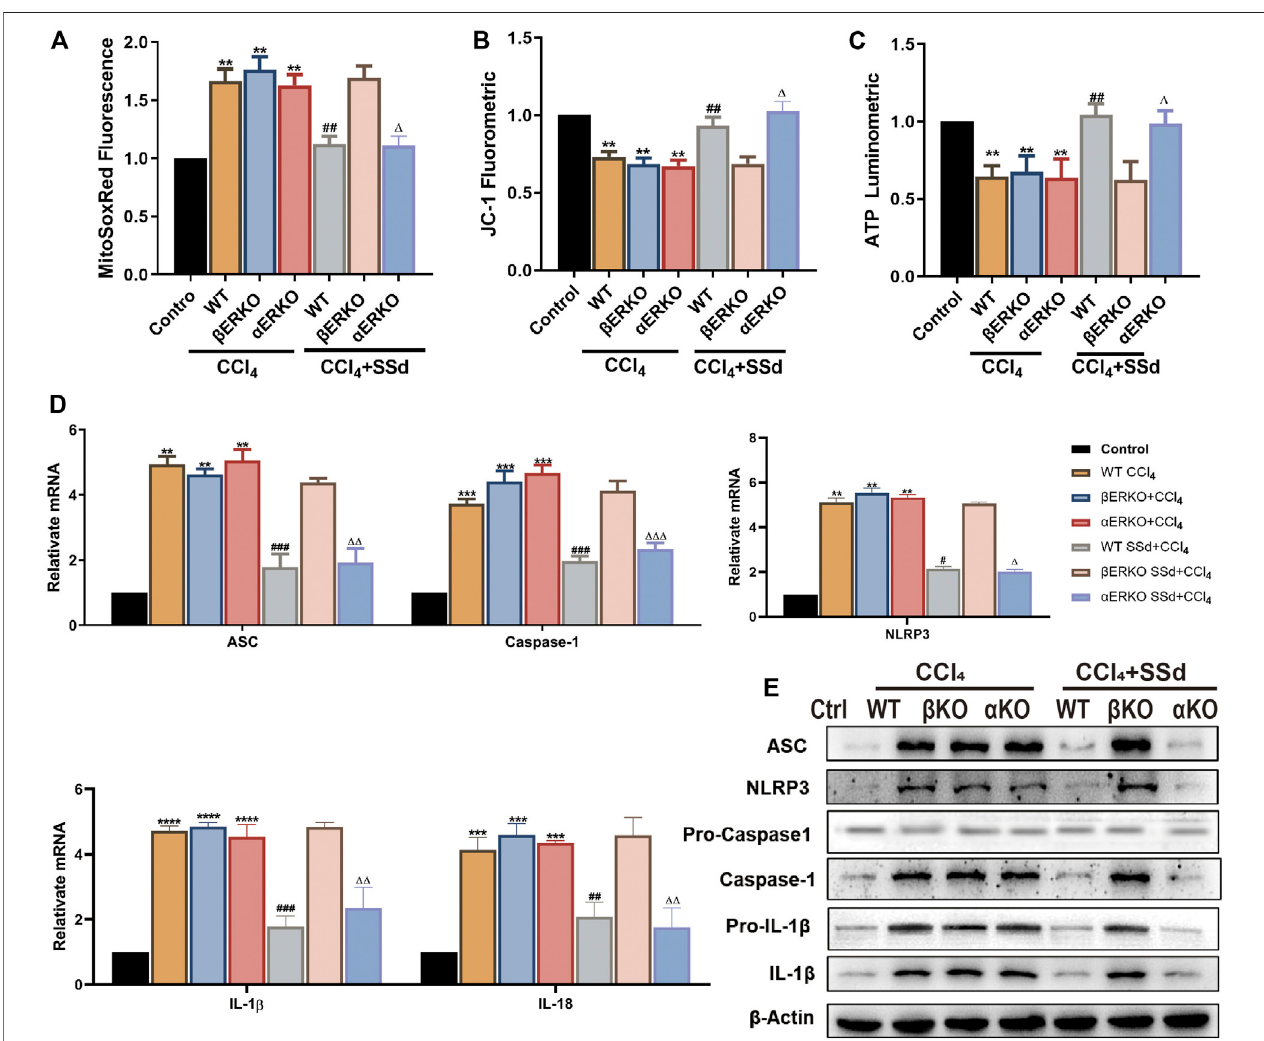
FIGURE 4 | De fi ciency of ER β , but not ER α , blocked the inhibitory effect of SSd against CCl 4 -induced mitochondrial dysfunction and NLRP3 activation in the liver (A) . ROS fl uorescence expression in the CCl 4 -induced ERKO mouse model combine with SSd or not, n = 6. (B) the mitochondrial JC-1 fl uorescence expression in liver tissue, n = 6. (C) ATP content, n = 6. (D,E) in fl ammasome complex expression was tested by western blot experiment and PT-PCR in each group, n = 3. Data are expressed in mean ± SEM; ** p < 0.01, *** p < 0.001, **** p < 0.0001, CCl 4 treated versus control in WT and ERKO mice; ## p < 0.01, ### p < 0.001, #### p < 0.0001, SSd + CCl 4 group versus CCl 4 group in WT mice; Δ P < 0.05, ΔΔ P < 0.01, ΔΔΔ P < 0.001, ΔΔΔΔ P < 0.0001, SSd + CCl 4 group versus CCl 4 group in α ERKO